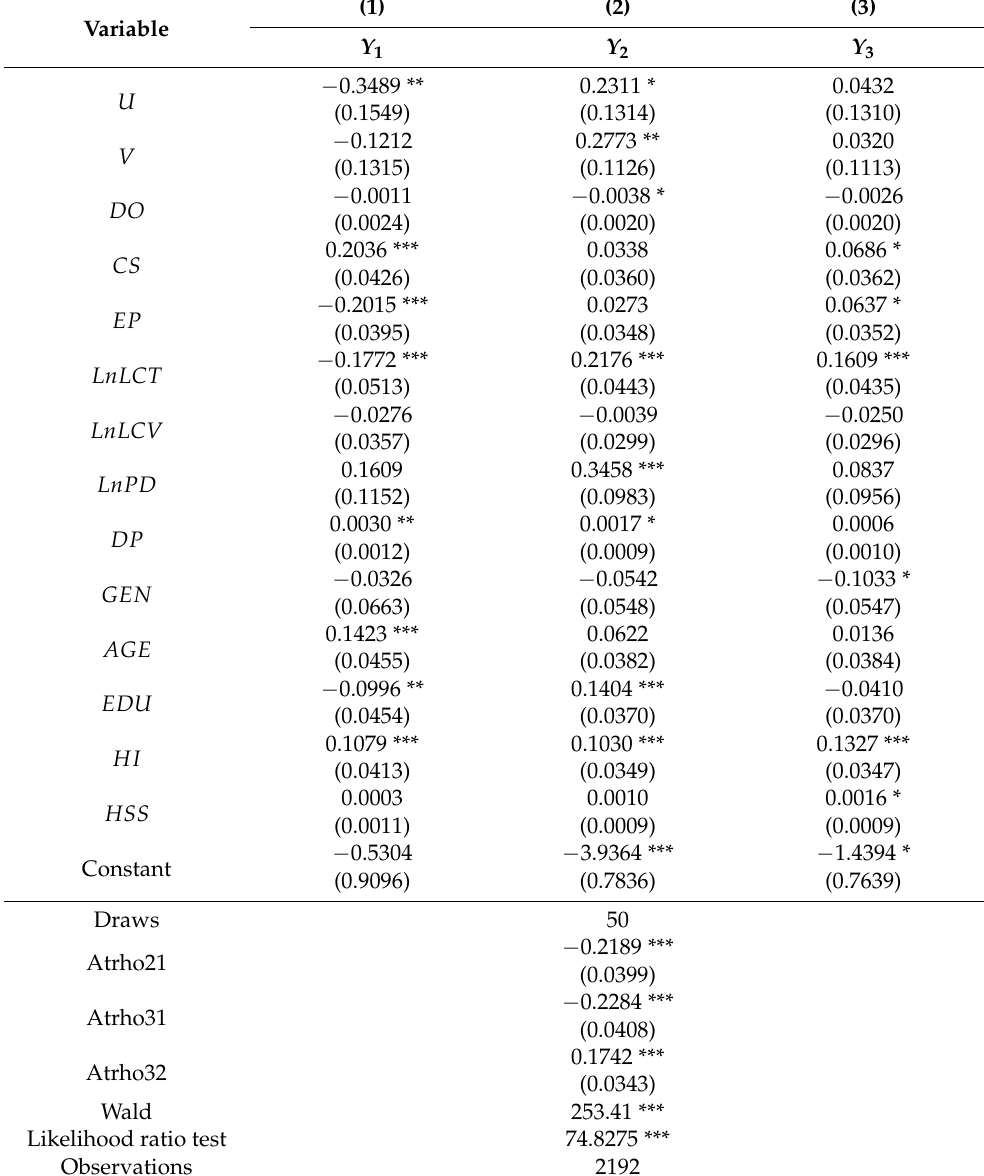
Table 7. Heterogeneity regression results of the types of land use planning.